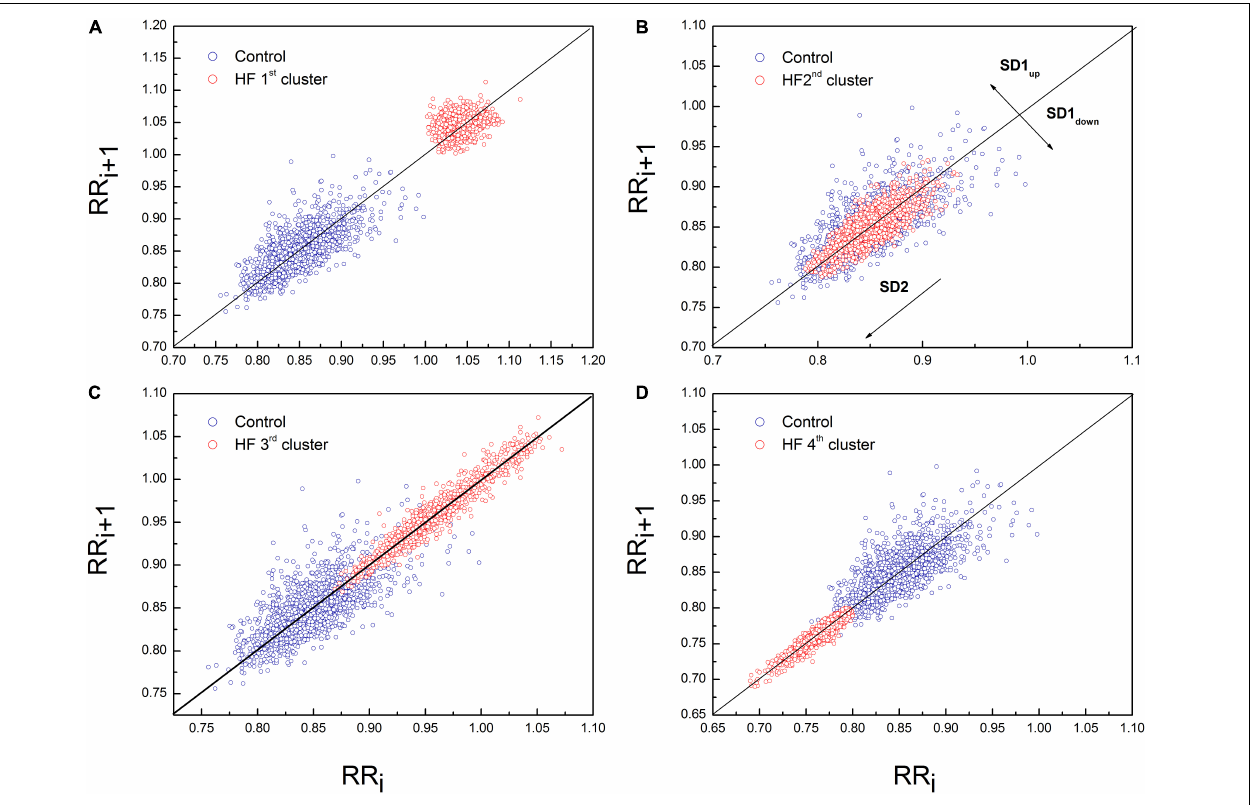
FIGURE 5 | Representative example of Poincaré plot in the first (A) , second (B) , third (C) , and fourth (D) cluster of heart failure patients with PP for one healthy subject. Patient from the first cluster had SD1 = 10.10 ms, SD2 = 12.80 ms, C up = 62.72% and C down = 37.28%. Patient from the second cluster had SD1 = 7.50 ms, SD2 = 22.30 ms, C up = 47.42% and C down = 52.58%. Patient from the third cluster had SD1 = 4.90 ms, SD2 = 35.30 ms, C up = 53.8% and C down = 46.2%. Patient from the fourth cluster had SD1 = 3.1 ms, SD2 = 17.7 ms, C up = 42.63% and C down = 57.37%. Control subject had SD1 = 13 ms, SD2 = 32 ms, C up = 57.42% and C down = 42.76%.